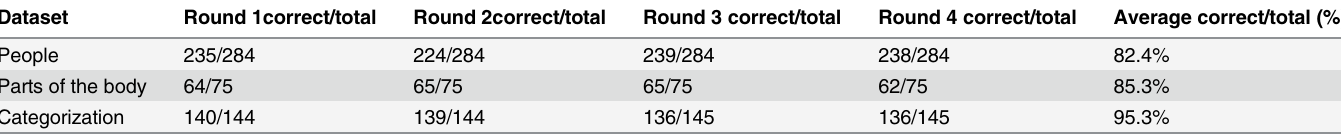
Table 4. Number of correct answers over the total number of expected answers in the test stage of the cross-validation rounds for the first three datasets. An answer to an interrogative sentence is considered valid only if it is correct both syntactically and semantically.